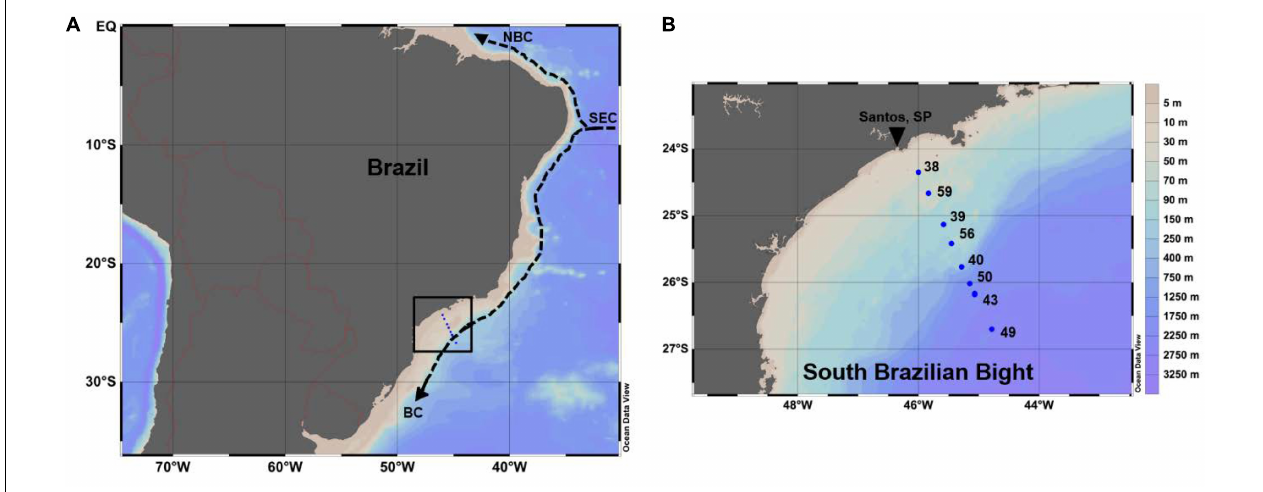
FIGURE 1 | (A) Southwestern Atlantic Ocean and (B) the South Brazilian Bight (SBB). Blue dots show the position of oceanographic stations occupied during the CARBOM-3 cruise in January 2013. Arrows in panel (A) shows the most prominent currents in the SW Atlantic: South Equatorial Current–SEC, North Brazil Current–NBC and Brazil Current–BC. Produced with Ocean Data View (Schlitzer,